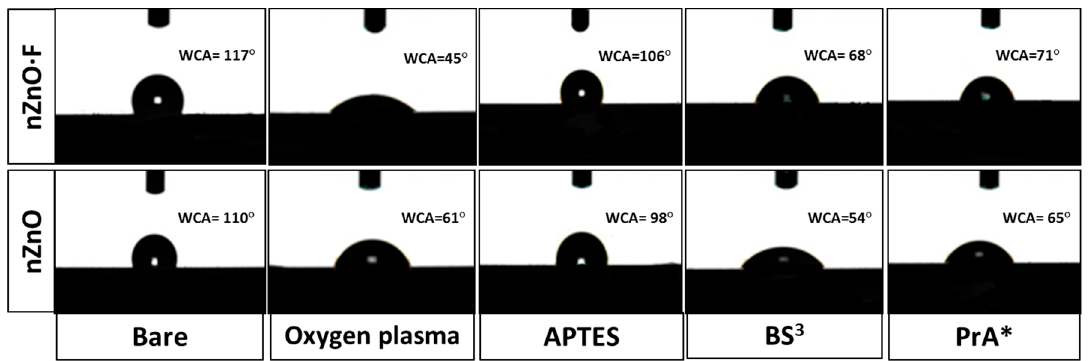
Figure 3. Wettability investigation of nZnO·F (upper line) and nZnO (lower line) samples. WCA measurements were performed after each functionalization step.